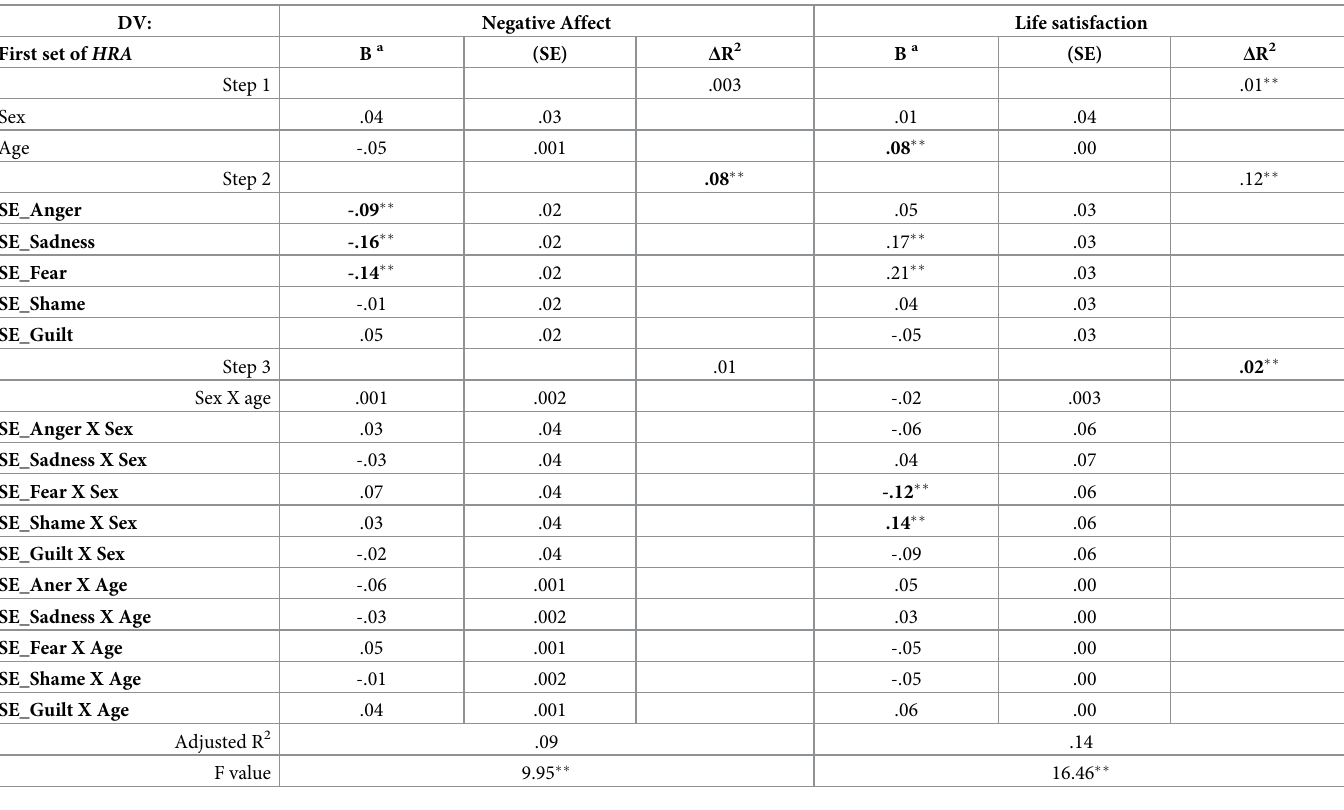
Table 5. Hierarchical regressions analyses ( HRA ) of sex, age and each of the MNESRES dimensions on negative affect and life satisfaction,